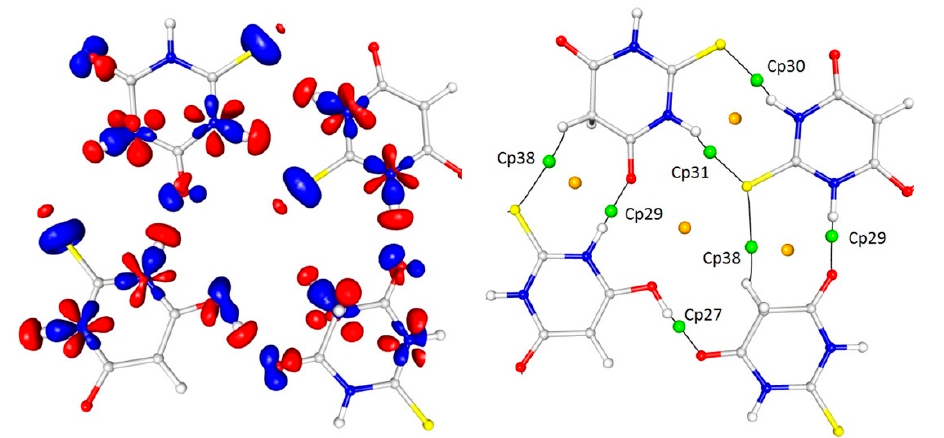
Figure 5. Static electron density map with the plane of the hydrogen bonds with the positions of BCPs (green) and RCPs (orange). Contours +0.15/ − 0.1 e.